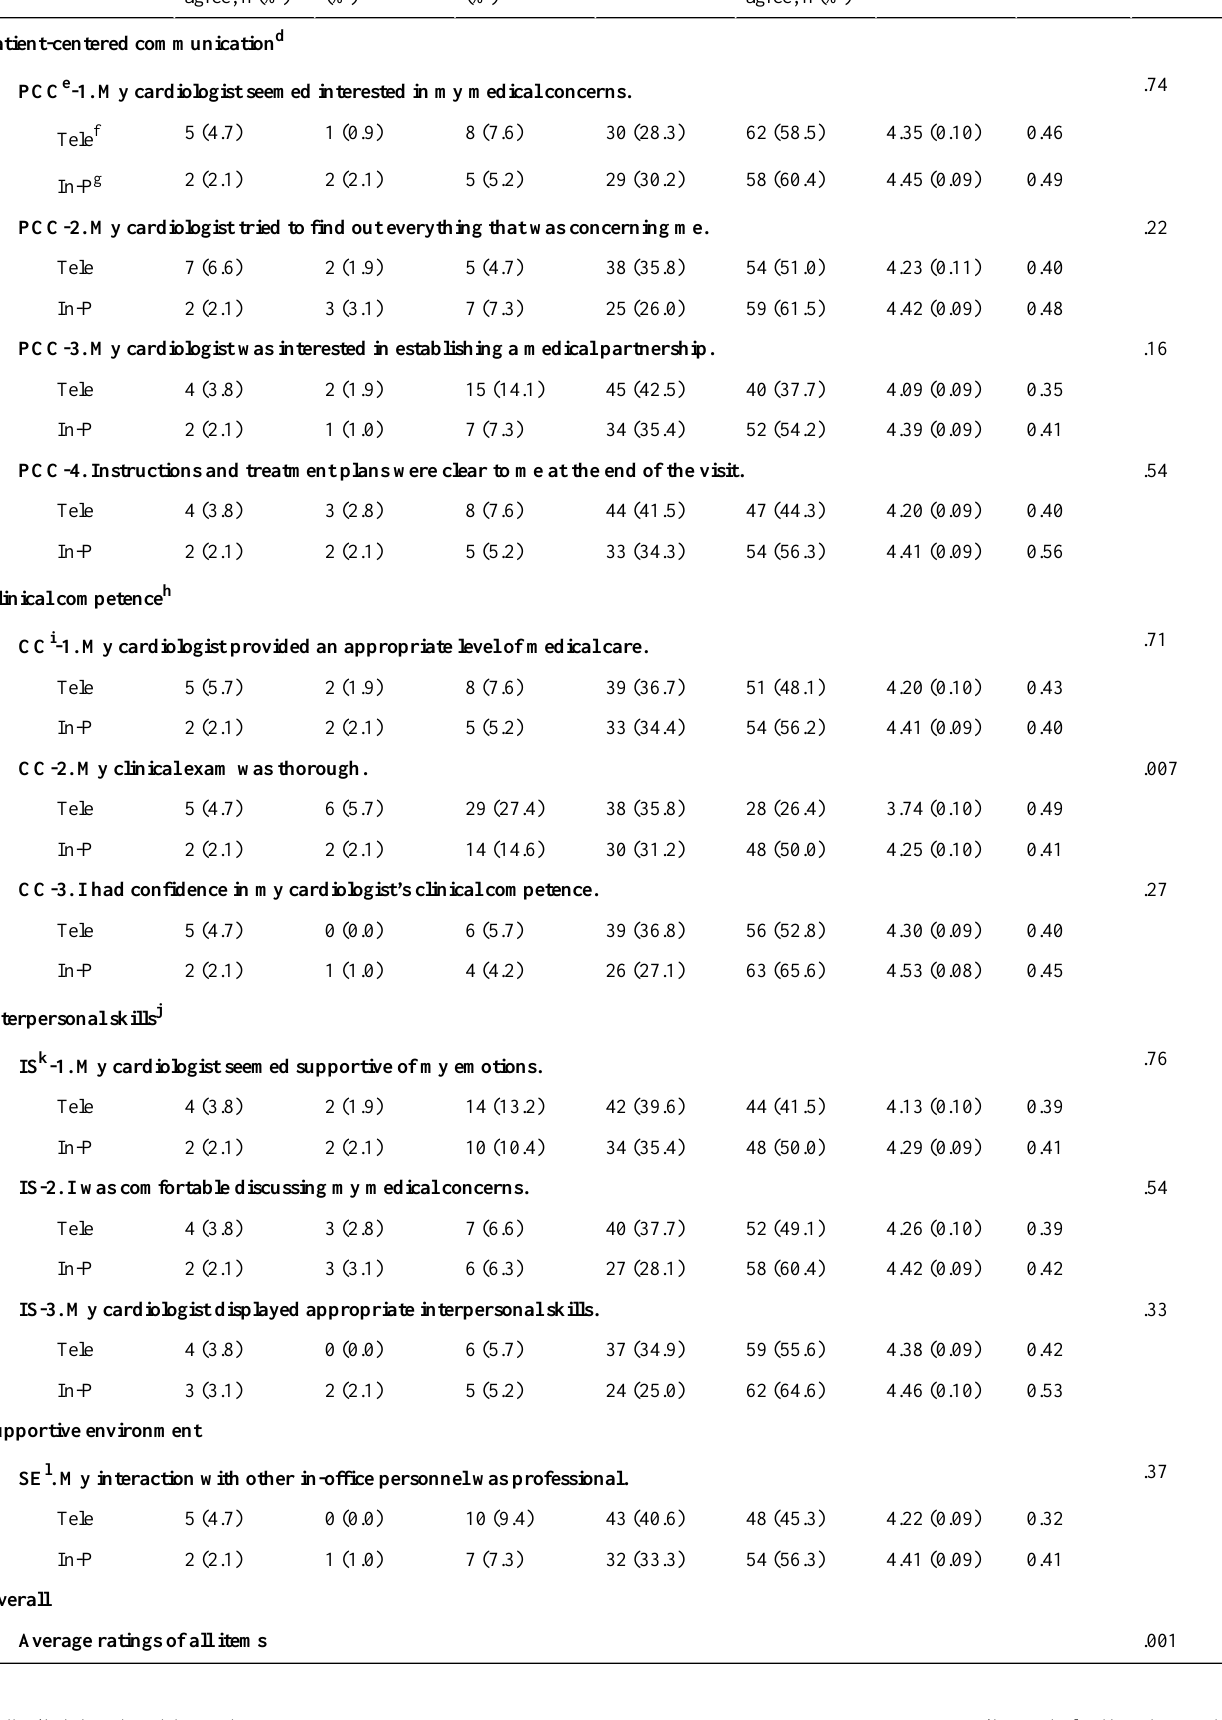
P value b r c Mean (SE) b